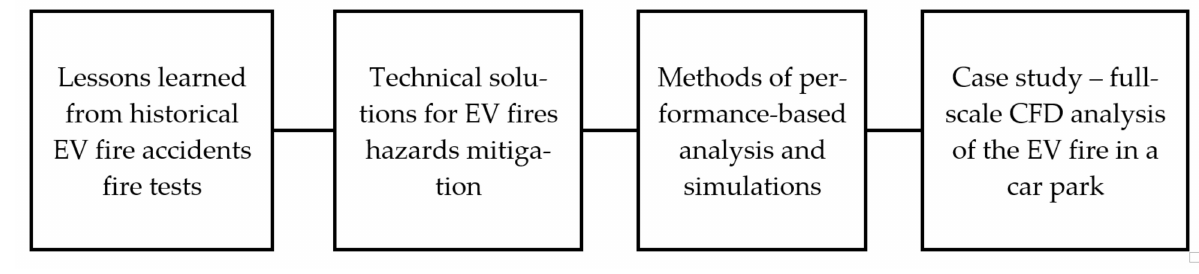
Figure 3. Realized analysis